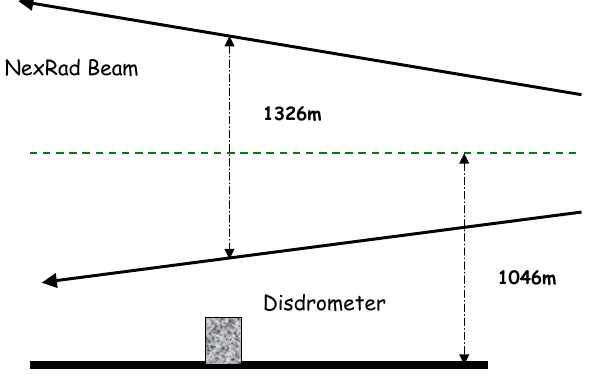
Fig. 4. Sketch to represent relative locations of the disdrometer and the NexRad radar beam.